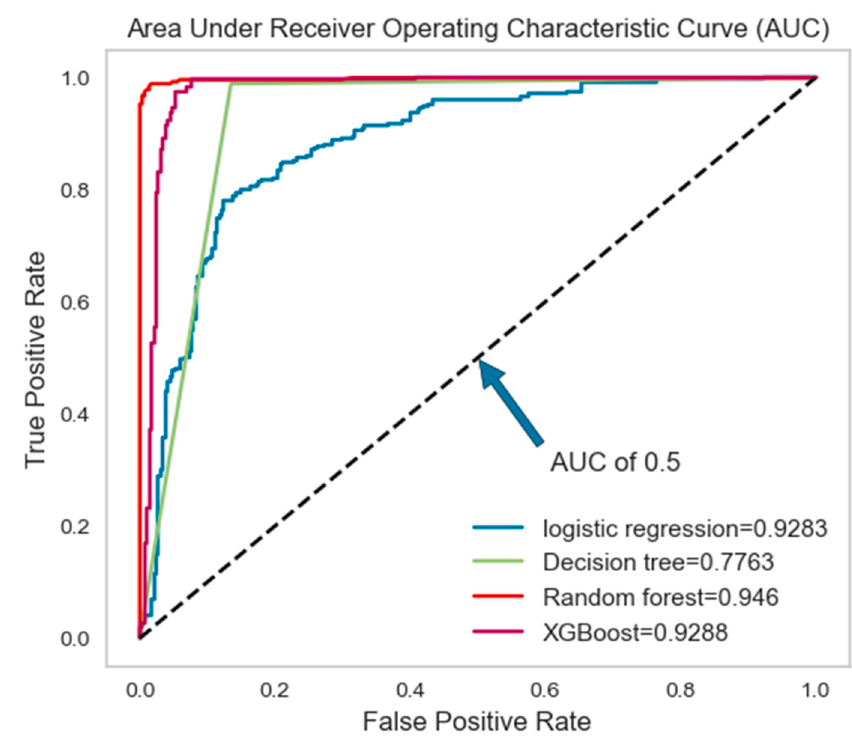
Figure 5. Areas under receiver operating characteristic curves for down-sampled